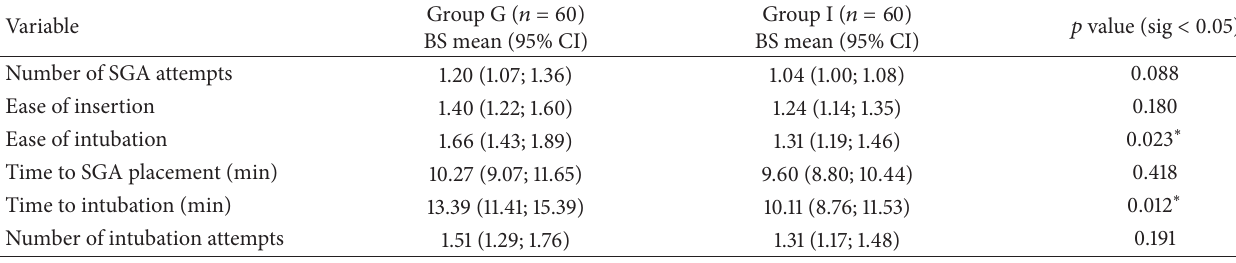
Table 3: Bootstrapped mean (95% CI) for device insertion and intubation parameters.